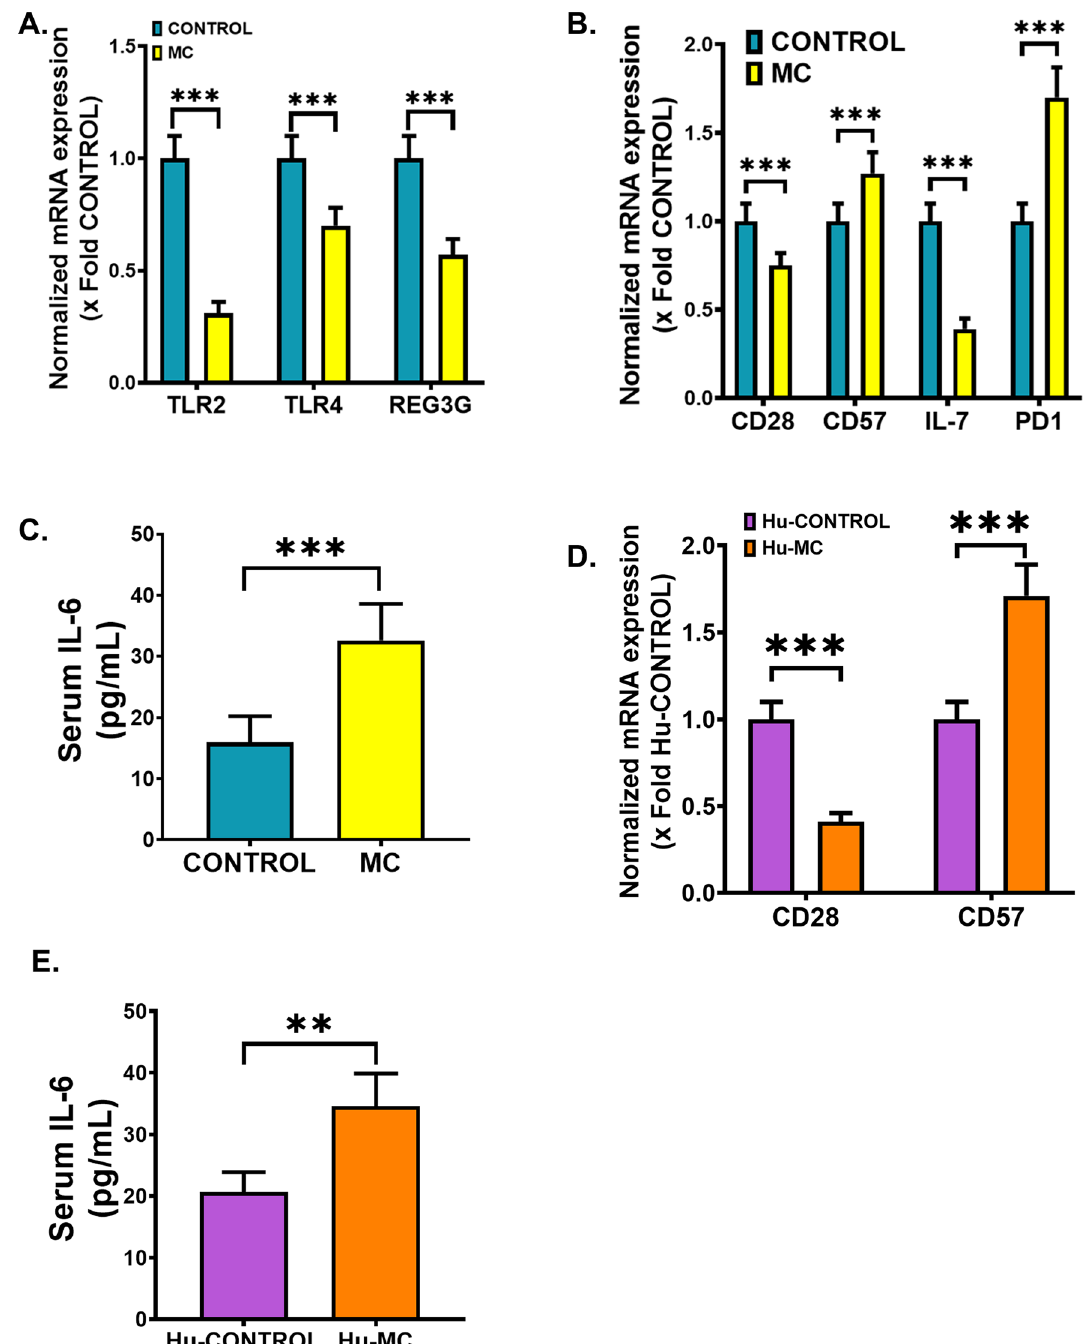
Figure 5. Early MC exposure caused pathological outcomes in the small intestine and elevated levels of systemic IL-6 in both WT mice and NSG™ mice. Normalized mRNA expression of ( A ) TLR2, TLR4, REG3G, and ( B ) CD28, CD57, IL-7, and PD1 against 18S in the small intestine of CONTROL and MC groups of mice and showed as the fold change of the CONTROL group (*** p < 0.001). ( C ) IL-6 (pg/mL) levels were measured in the serum of both CONTROL and MC mice groups and represented as bar graphs (**** p < 0.001). Normalized mRNA expression of ( D ) CD28, CD57 against 18S in the small intestine of Hu-CONTROL (NSG™ mice treated with vehicle only) and Hu-MC (NSG™ mice orally administered with MC for 2 weeks) groups of mice and showed as the fold change of the Hu-CONTROL group (*** p < 0.001). ( E ) IL-6 (pg/mL) levels were measured in the serum of both Hu-CONTROL and Hu-MC mice groups and represented as bar graphs (**** p < 0.001). All data were represented as mean ± SEM, statistical significance was tested using unpaired t-test between the two groups, followed by Bonferroni Dunn Post hoc